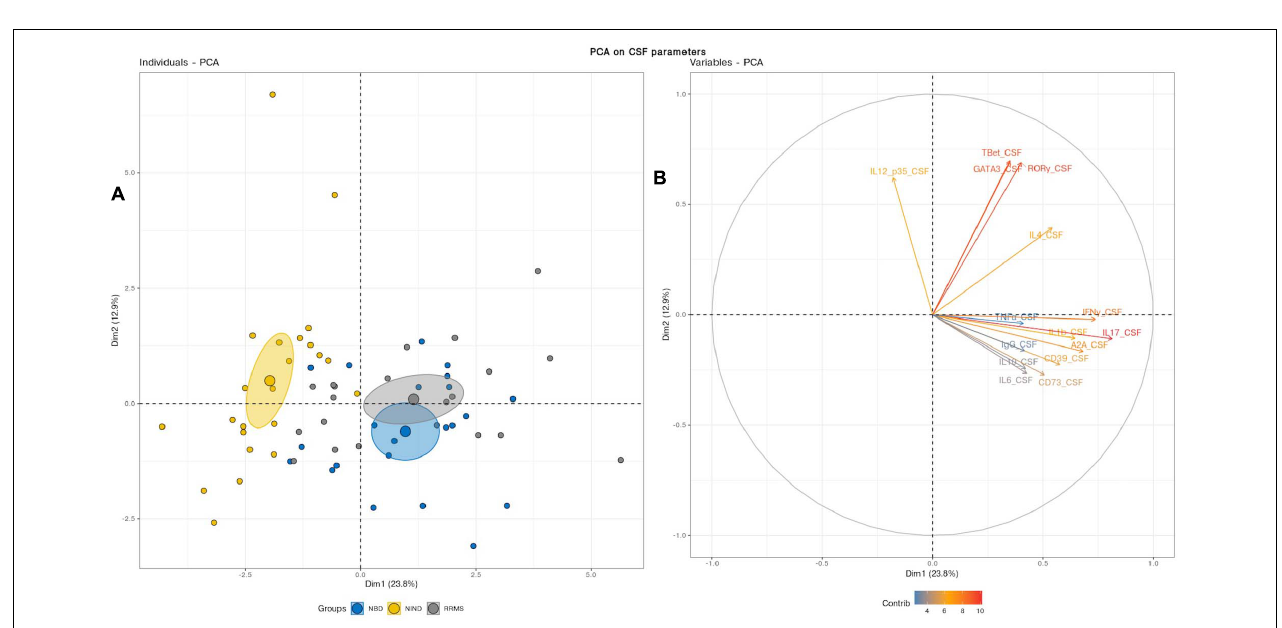
FIGURE 1 | Blood variables fail to differentiate the NIND, NBD, and RRMS groups. (A) Individuals plot: samples are represented by dots and each color represents a group of patients. (B) Variables plot: vectors represent the 15 most influencing variables for each of the principal components PC1 and PC2. The longer the arrow is, the more it influences the variance. The ellipses indicate 95%